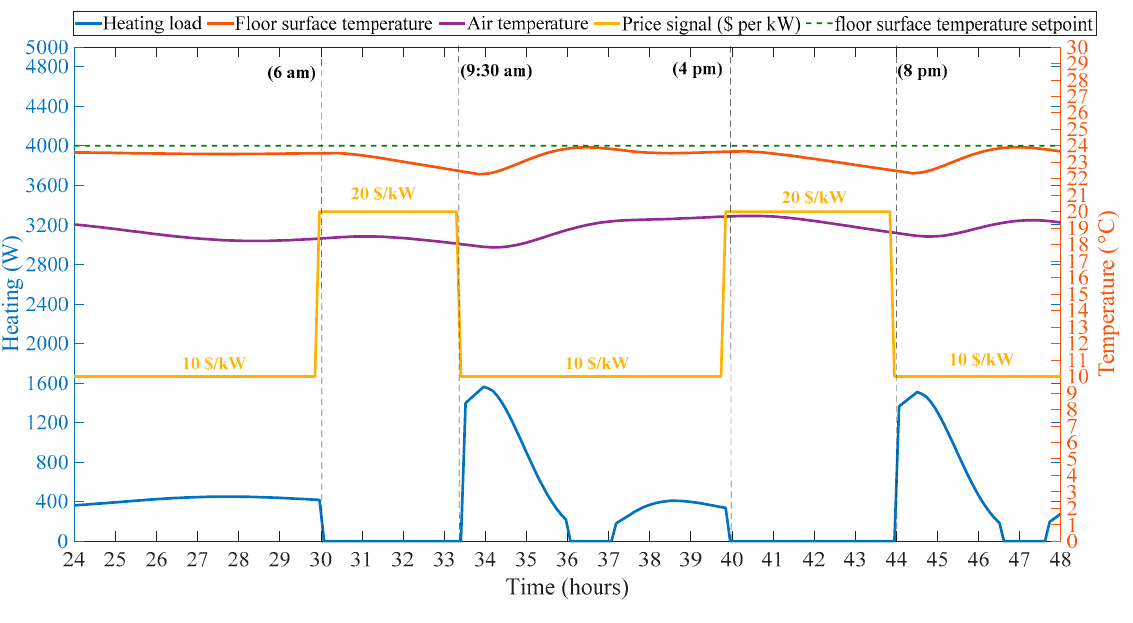
Figure 9. Reactive responses to sudden increase in the price signal.